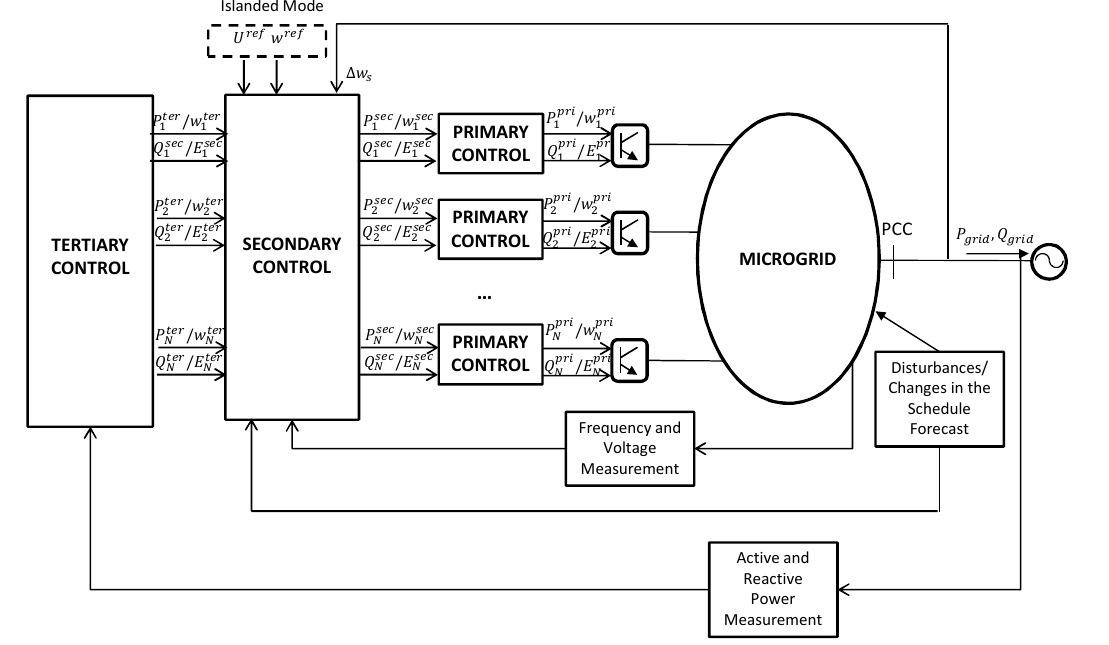
Figure 2. Microgrid control level architecture.